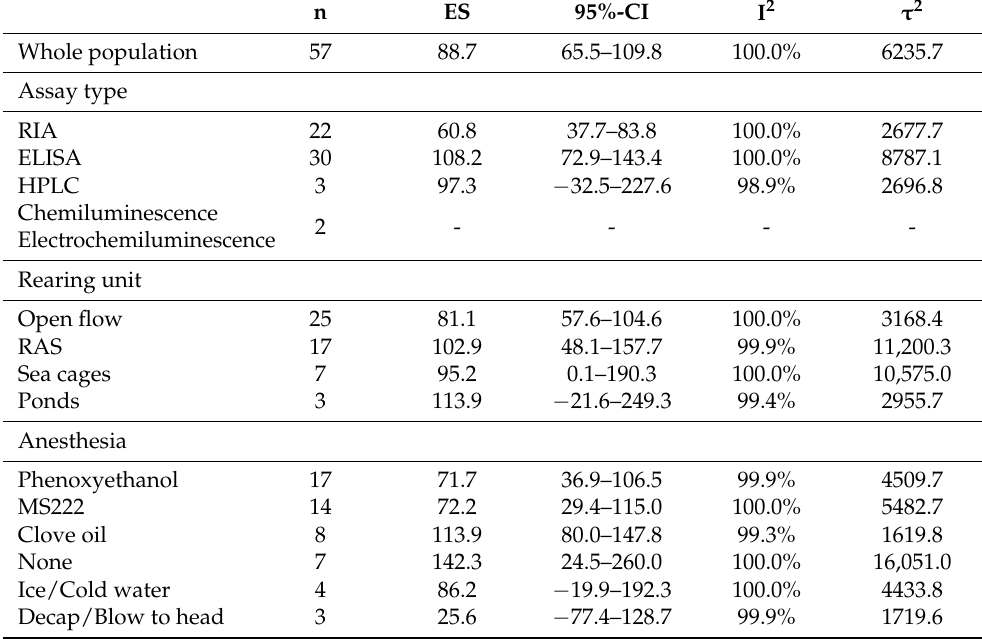
Table 3. Results of the meta-analysis regarding basal cortisol levels, including subgroup